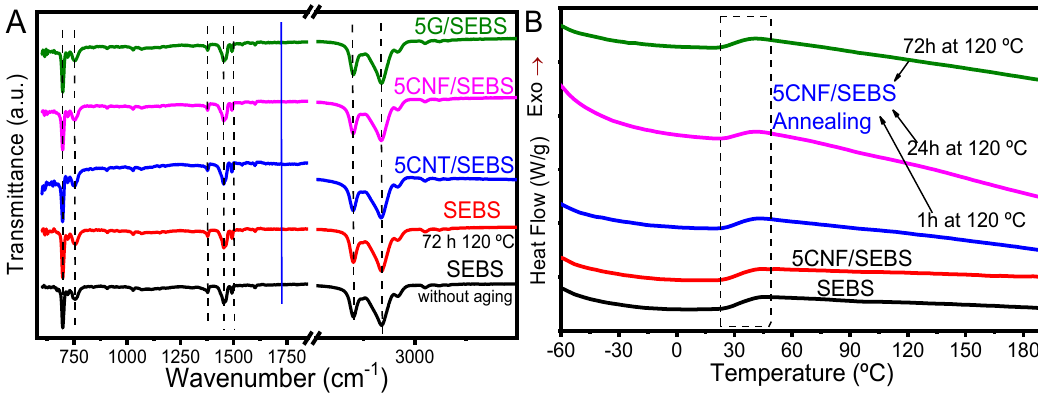
Figure 7. Annealed samples measured by ( A ) FTIR and ( B ) DSC. Annealed SEBS and respective composites with 5 wt.% at different annealing times from 1 to 72 h, at 120 °C.